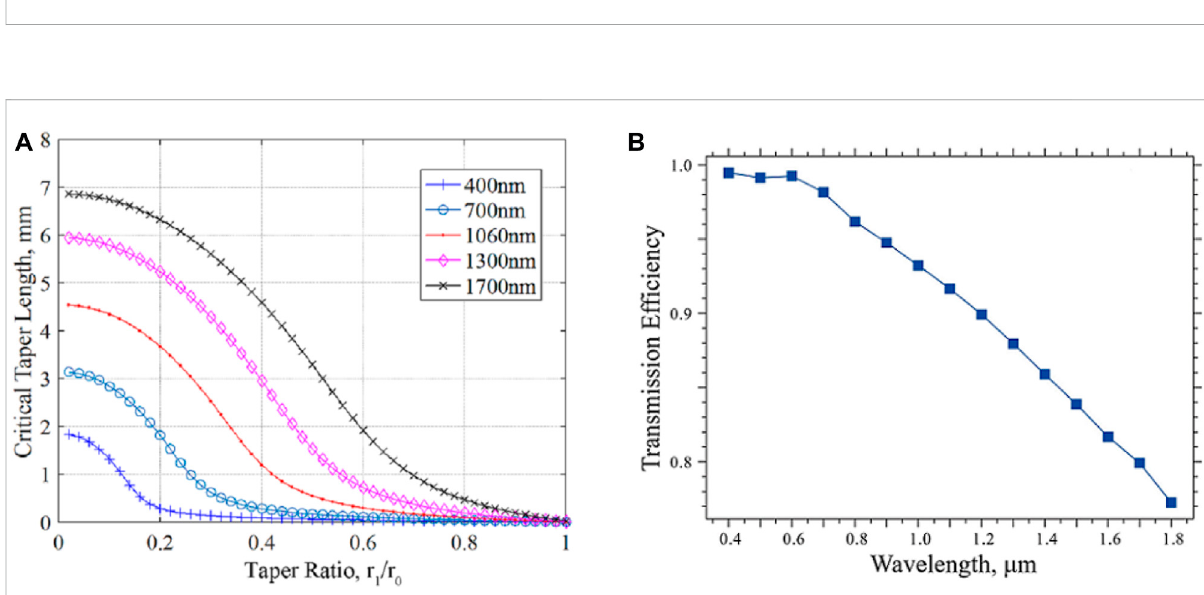
TR (cid:3) r r 1 / 0 . In order to reduce the transmission loss of the tapered region, each input fi ber should satisfy the criteria of adiabatic tapering, that is, the maximum Ω taper of the tapered region should not exceed the fundamental mode diffraction diffusion angle there. This maximum Ω taper is called the critical tapering angle, and the corresponding L taper is